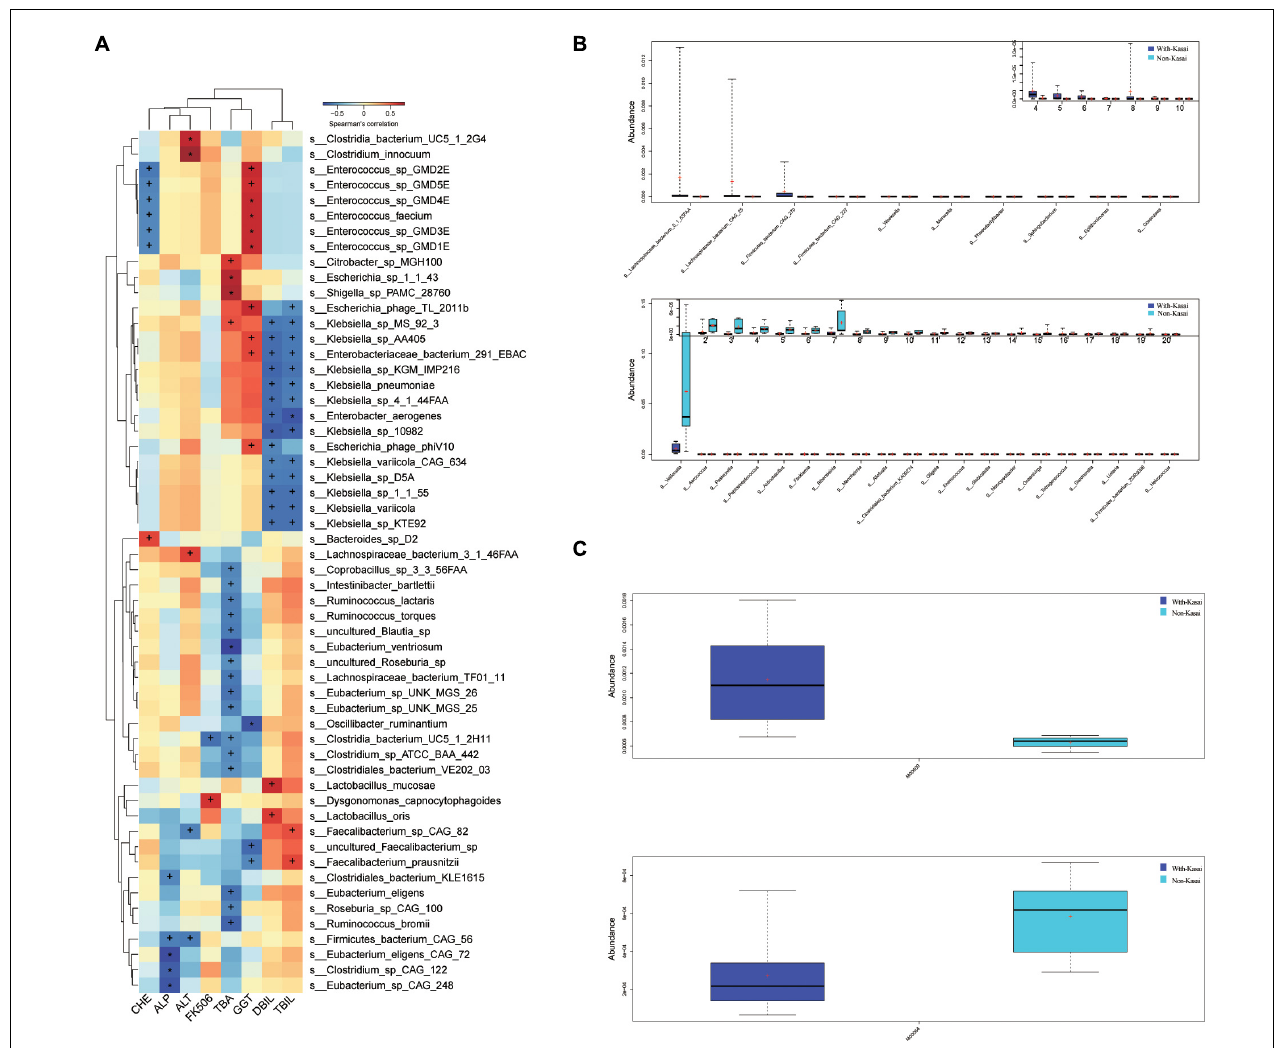
FIGURE 6 | (A) Spearman correlations between species and clinical indices. The x -axis represents the environmental factors, and the y -axis the species. The depth of the color indicates the correlation between species and environmental factors ( + P < 0.05, * P < 0.01). Blue denotes a negative correlation and red a positive correlation. (B,C) The effect of prior Kasai surgery on the gut microbiota after liver transplantation. (B) Species with significantly different abundances at the genus level in the with-Kasai and non-Kasai individuals (Wilcoxon rank-sum test, P < 0.05). The upper panel shows the abundance ranking of species in the with-Kasai group, and the lower panel the abundance ranking of species in the non-Kasai group. The x -axis represents the different taxa, and the y -axis the abundance of taxa. Different colors represent different groups. Lines inside the boxes indicate medians, “ + ” indicated means. (C) Functional profiles with significantly different abundances at the module level between the two groups (Wilcoxon rank-sum test, P < 0.05). Different colors represent different